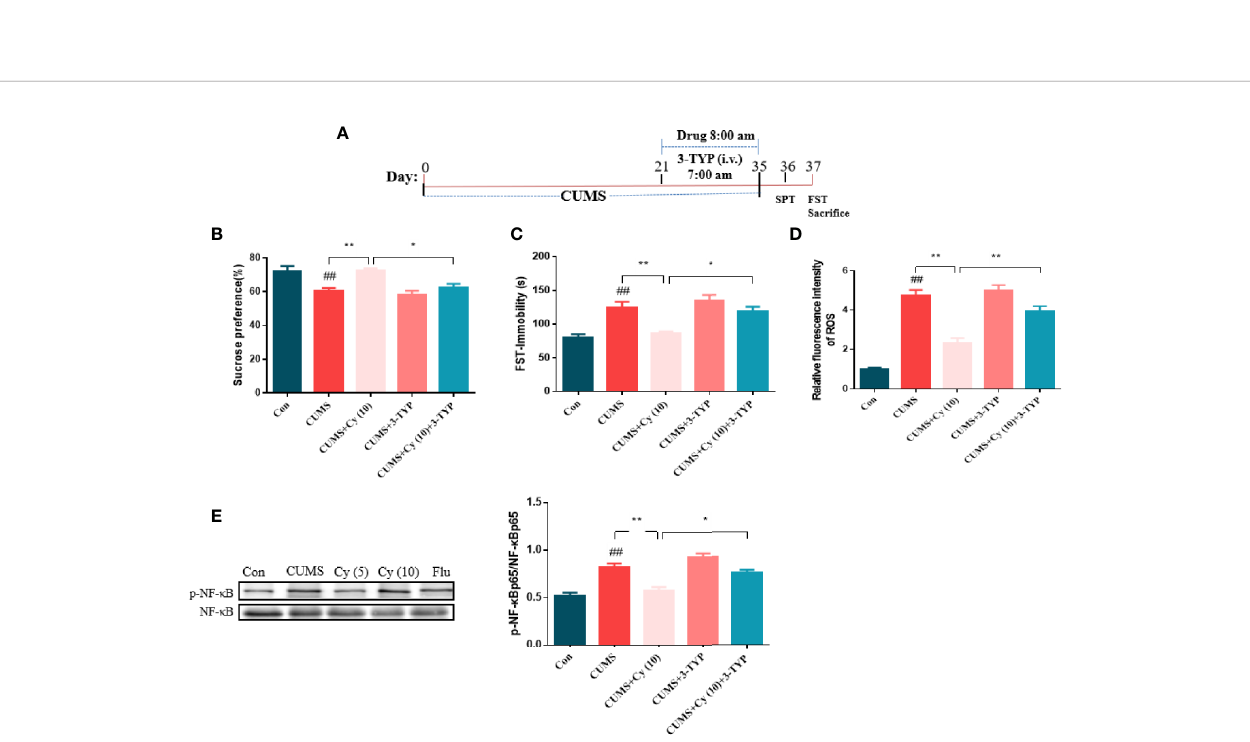
FIGURE 5 | Effect of SIRT3 blockage on Cy-related attenuation on depressive behaviors, ROS production and NF- k B expression. 3-TYP was applied to inhibit SIRT3 signal (A) . The protective ef fi cacy of Cy on SPT (B) , FST (C) , ROS production (D) , and NF- k B expression (E) were all reversed when co-administrated with SIRT3 inhibitor 3-TYP. Data are represented as mean ± SEM. ## p < 0.01 vs. Con group. * p < 0.05 and ** p < 0.01 vs. CUMS + Cy (10 mg/kg)